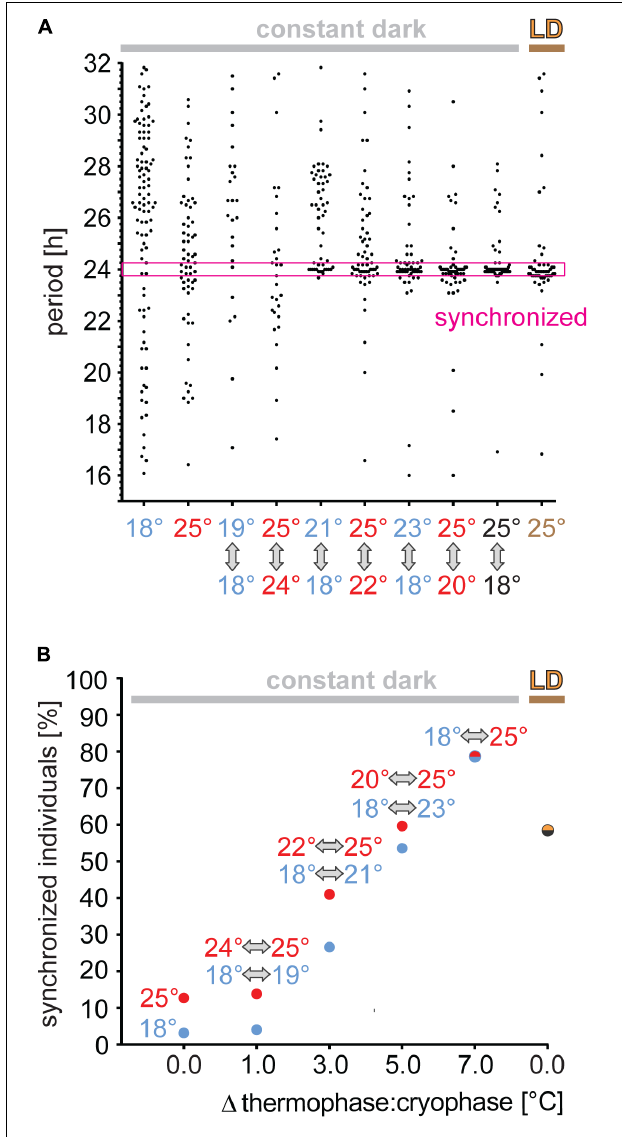
FIGURE 4 | Synchronization efficiency to thermoperiodic cycles depends on the temperature range. Adult males developing in long photoperiod (L18:D6) were released to thermoperiodic cycles (thermophase 18 h matched the previous photophase of LD) with 1, 3, 5, or 7 ◦ C steps. Periodicity of locomotor activity is determined from 10 days with chi-square algorithm and males with period 24 h ( ± 15 min) are considered as synchronized [magenta window in panel (A) ]. As a positive control, males synchronized by LD regime at a constant 25 ◦ C (brown) are used. As a reference, τ in constant DD at 18 ◦ C (blue) or at 25 ◦ C (red), respectively, are plotted. The percentage of synchronized males is shown for each temperature steps in panel (B)